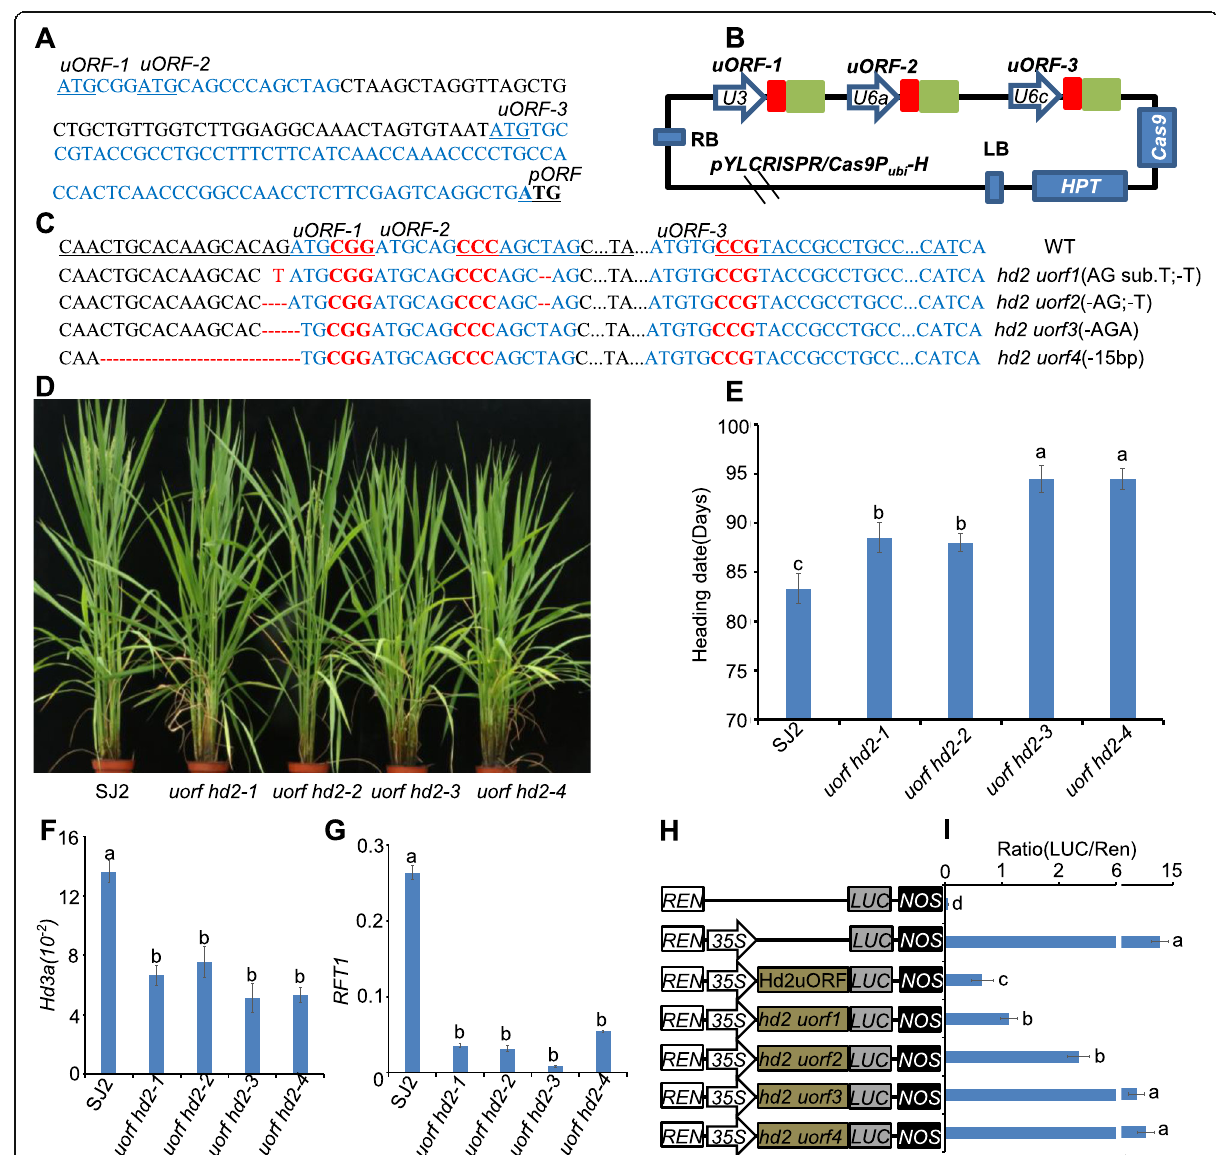
Fig. 1 Editing of Hd2 uORFs delays rice heading date. A There are three uORFs in 5 ’ leader sequence(blue) of Hd2 , and uORFs putative initiation codon is underlined.pORF is shown in bold with underlined. B Schematic diagram of the CRISPR/Cas9 vector. Three target sequences ( uORF- 1,uORF-2,uORF-3 ) fused with sgRNA scaffolds were driven by respective U3 or U6 promoters. The three sgRNA expression cassettes were sequentially inserted into the binary vector pYLCRISPR/Cas9P ubi - H . Red boxes indicate three target sequences and green boxes indicate sgRNA scaffolds. HPT , hygromycin phosphotransferase gene. C Four homozygous mutants (T 2 generation) of hd2 uorf1 to hd2 uorf4 obtained by CRISPR/ Cas9 editing. The uORF sequence (blue) is shown with the sgRNA target site underlined and the protospacer-adjacent motif shown in red. The nucleotide changes are labeled in red. ‘ - ’ means deletion and sub. means substitution. D Representative flowering image of mutants uorf hd2-1 to uorf hd2-4 indicated genotypes under NLD in summer at Harbin. Wide type SJ2 was used as control. E Flowering time of each genotype under NLD conditions. Data are means± SE ( n = 20). F and G qRT-PCR analysis of Hd3a ( F ) and RFT1 ( G ) transcription level in indicated lines and SJ2. Rice UBIQUITIN gene was used as the internal control. Means and standard deviations were obtained from three biological replicates. Data are means± SE ( n = 3). H Schematic diagrams of the reporter plasmids used in rice protoplasts transient assay. REN, Renilla luciferase; LUC, firefly luciferase. I The LUC activity in rice protoplasts with indicated reporter plasmids. Data are means±SE ( n =3). Statistically significant differences are indicated by different lowercase letters ( P < 0.05, one-way ANOVA with Tukey ’ s significant difference